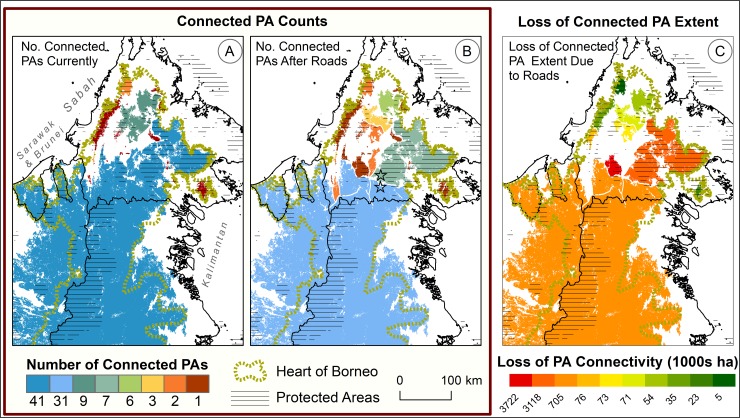
Number of inter-connected protected areas (PAs) per intact forest patch in the northern Heart of Borneo region, (A) currently and (B) after planned road developments (center), as well as (C) related losses of inter-connected PA extent per patch due to planned road developments (right). Note: Panels A and B show ‘before’ and ‘after’ scenarios regarding planned road development, while panel C shows anticipated changes due to the planned development relative to the present. In Panel B, two grey stars denote the two main post-development patches descendent from the current trans-boundary patch, namely the ‘confined’ trans-boundary patch in southern Sabah and the large patch in Kinabatangan and Lahad Datu districts to its north. Panel C shows changes for the 10 post-development intact forest patches having the greatest post-development PA extents. The losses of inter-connected PA extent in Panel C are therefore not necessarily the greatest absolute losses pending. Absolute losses may be greater for some patches entirely disconnected from PAs by planned road development.